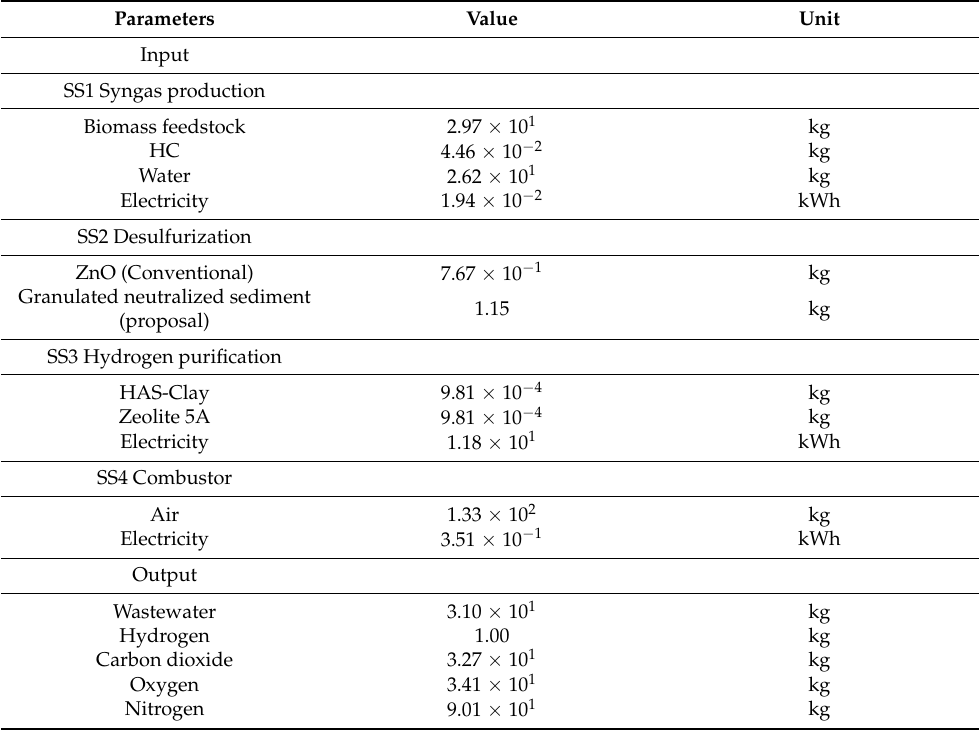
Table 4. Inventory data of hydrogen, 1 kg